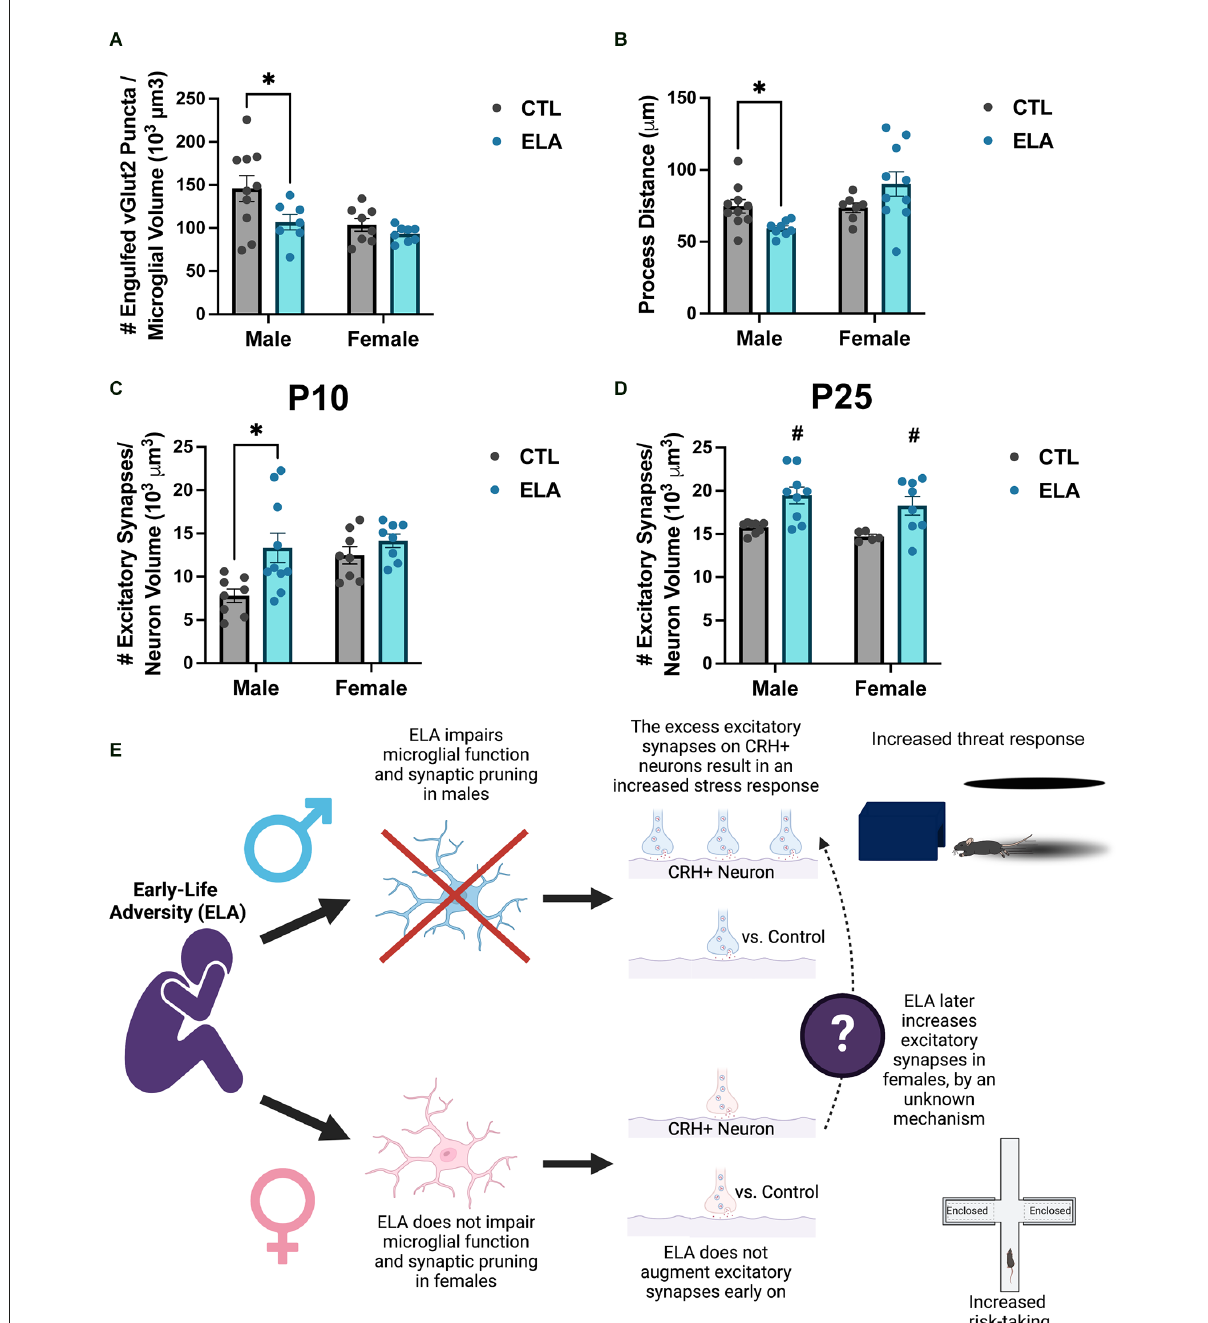
FIGURE2 ELA alters microglial function and synaptic pruning in a sex-specific manner, leading to sex differences in the ELA-induced augmentation of excitatory synapse number on PVN-CRH+ neurons across development. (A) ELA diminishes the number of excitatory synaptic puncta engulfed by microglia at P8 in male, but not female, mice (trend for ELA x Sex interaction; F (1,29) = 1.74, p = 0.1; post-hoc test, p < 0.05). (B) ELA inhibits the microglial process dynamics, as measured by total distance moved by microglial processes, at P8 in males, but not in females, even tending to do the opposite (significant ELA x Sex interaction; F (1,29) = 7.38, p = 0.01; post-hoc test, p < 0.05). (C) ELA augments the number of excitatory synapses on PVN-CRH+ neurons at P10 in male, but not female, mice (trend for ELA x Sex interaction; F (1,30) = 2.45, p = 0.1; post-hoc test, p < 0.05). (D) By P25, there is a significant increase in the number of excitatory synapses on PVN-CRH+ neurons in both male and female ELA mice (significant main effect of ELA; F (1,26) = 17.5, p = 0.0003). (E) Conceptual figure displaying the proposed microglia-dependent mechanisms by which ELA results in sex-specific behavioral outcomes. Figure created with BioRender.com. Data are mean ± SEM; p ≤ 0.1 criteria used for interaction terms to trigger subdivision for lower-order tests; ∗ p < 0.05 post-hoc test; # p < 0.05 main effect of ELA; adapted from Bolton et al.